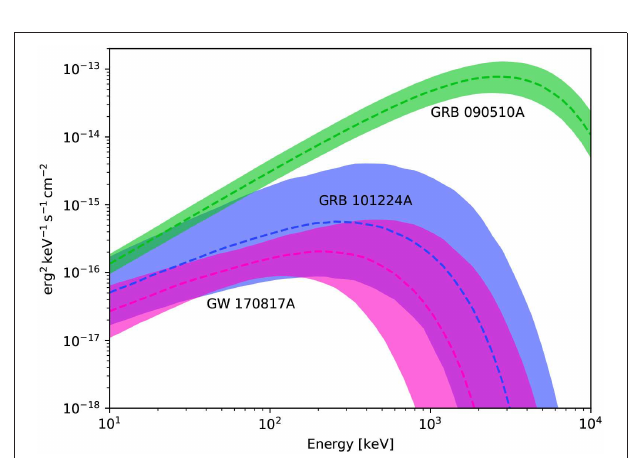
FIGURE 3 | Comparison of the observer-frame ν F ν gamma-ray spectrum of GRB 170817A with that of GRB 101224A, and that of the distant and likely on-axis GRB 090510A. The shaded regions indicate the 1 σ confidence interval for the